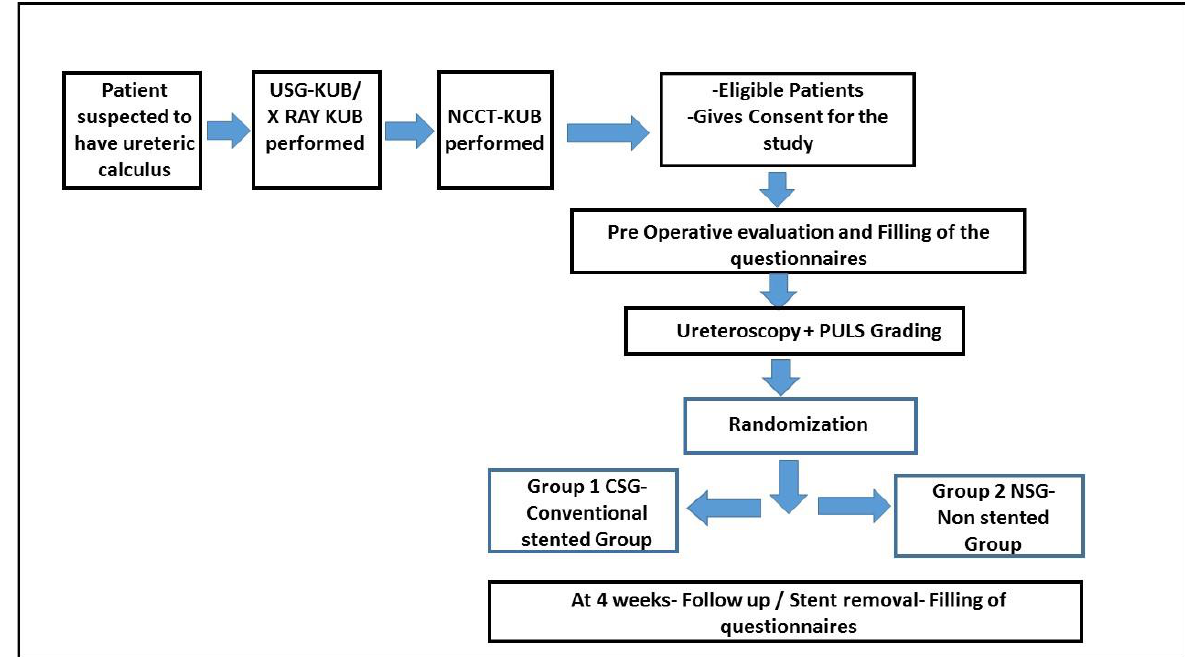
Figure 1. Methodology of the study.